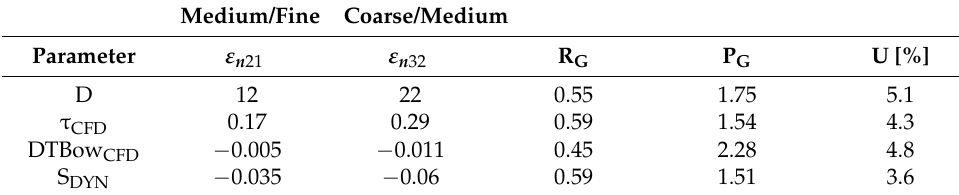
Table 6. Uncertainty